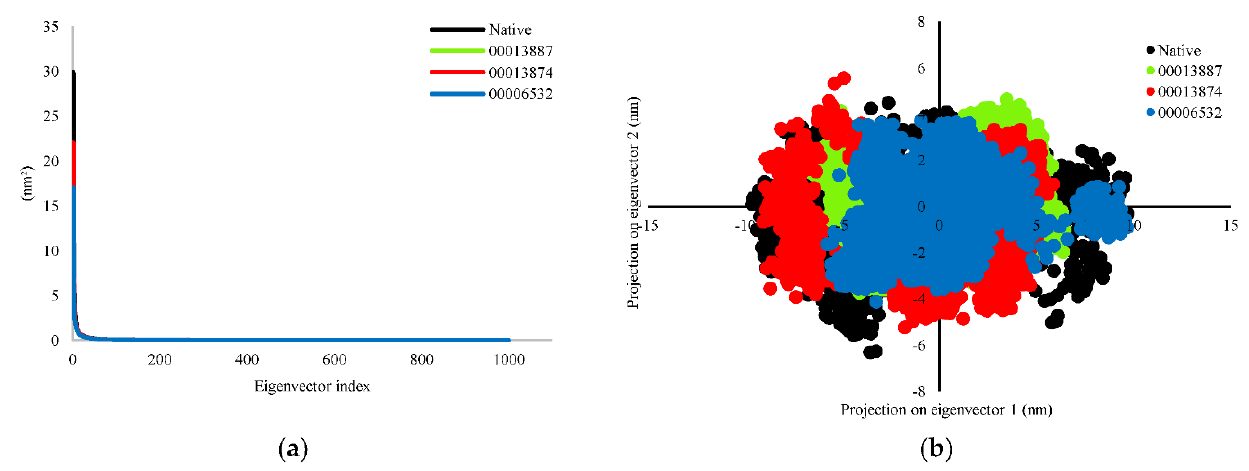
Figure 4. Evaluation of ( a ) eigenvalues of the covariance matrix and ( b ) 2D projection of trajectory during MD simulations. The complex of protein-native ligand (NAD) and protein-hit ligands have been represented in different colors. NAD (black), C00013887 (green), C00013874 (red), C00006532 (blue).